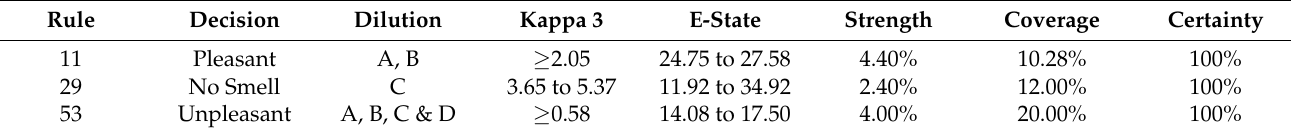
Table 7. Sample rules generated from reduct